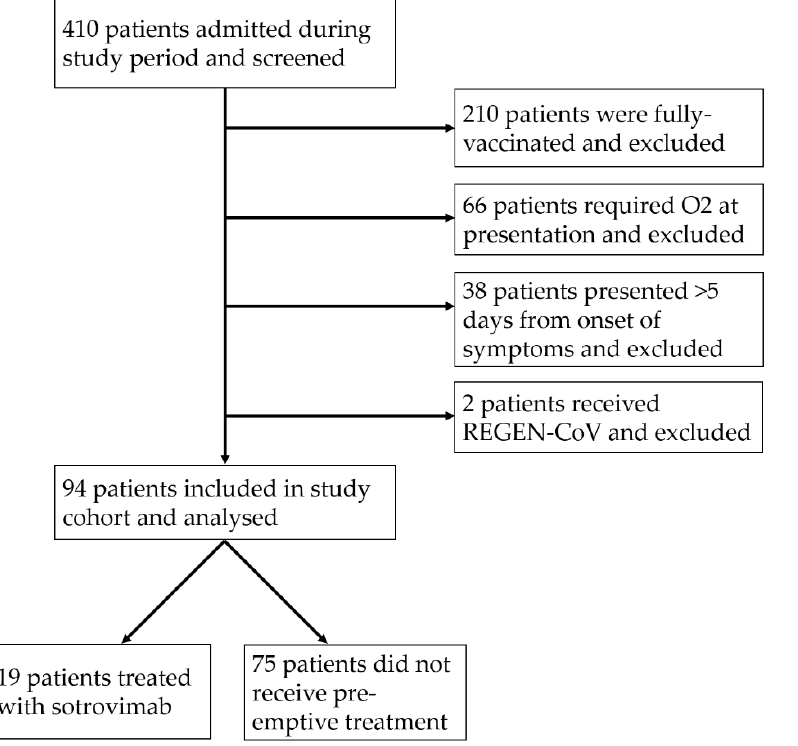
Figure 1. Study flowchart. Table 1. Baseline characteristics of study cohort.